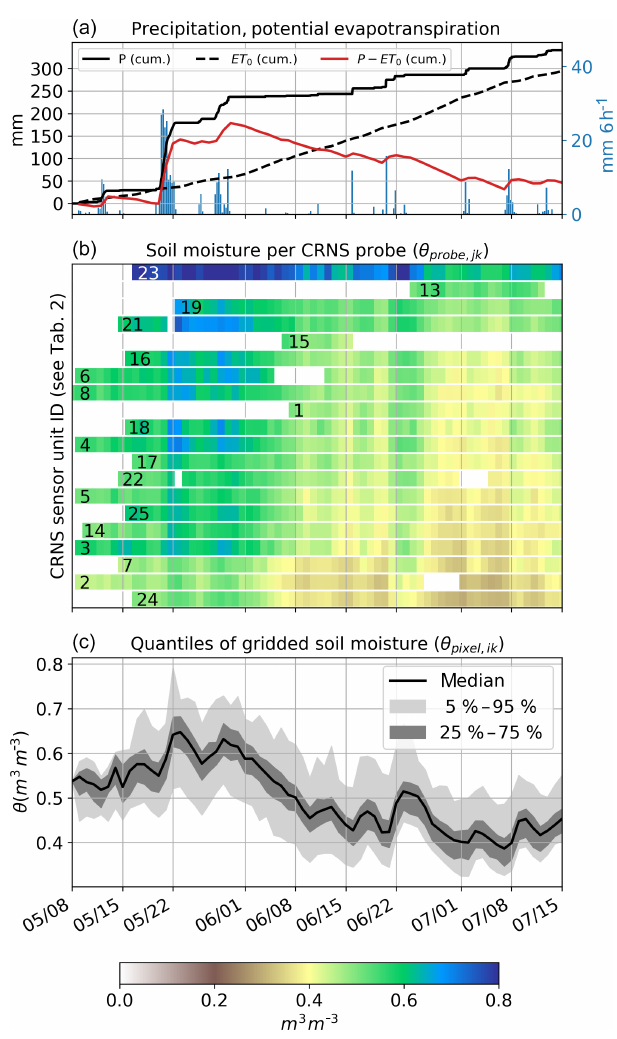
Figure 9. Dynamics of meteorological variables and soil moisture as estimated from neutron count rates. (a) Cumulative precipita- tion P , reference evapotranspiration ET 0 (FAO, 1998) based on Penman–Monteith, and the difference P − ET 0 . (b) Soil moisture θ sensor ,jk estimated from neutron count rates for each of the CRNS sensors, where the sensors have been sorted from bottom to top in ascending order based on average soil moisture – the white spaces indicate periods of missing data; please note that sensor nos. 9–12 are not included in this overview because they did not record valid data during the time of collocation with the calibrator sensor or the manual sampling campaign. (c) Temporal dynamics of different soil moisture quantiles after the soil moisture estimates have been inter- polated to a grid (see main text for explanation).